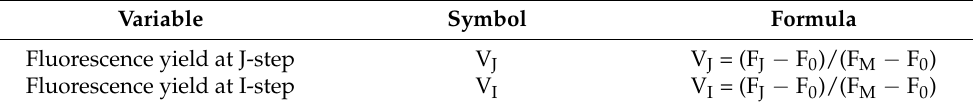
Table 4. Selected variables calculated from the time-course of fast fluorescence induction curves. F 0 , F J , F I and F P —fluorescence yields measured at O-step (0.05 ms), J-step (~2 ms), I-step (~20 ms) and P-step (200–400 ms) of fluorescence induction curve (modified and compiled from [166,189,195]). Variable Symbol Formula Fluorescence yield at J-step Fluorescence yield at